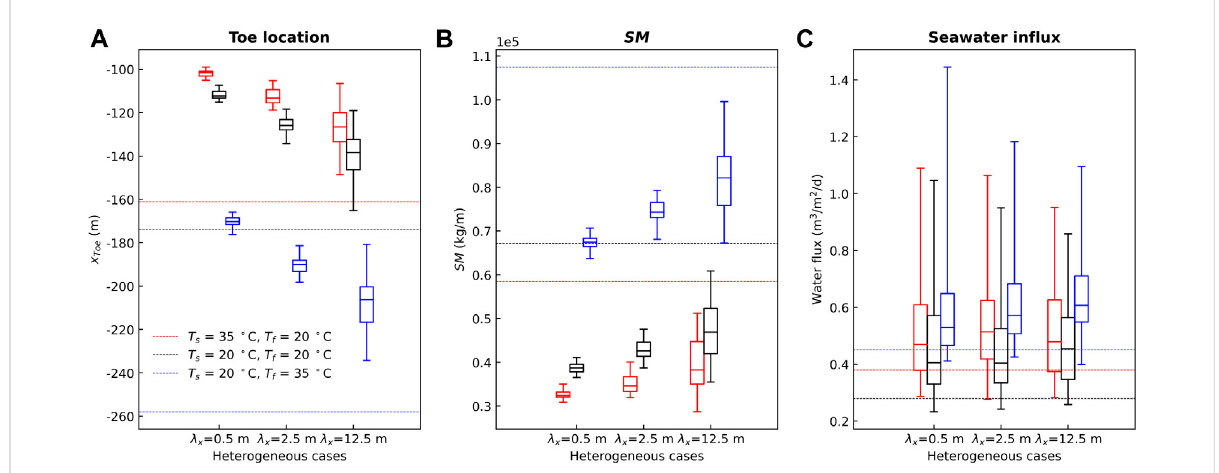
FIGURE 11 Box plots ( n = 50) for heterogeneous aquifers under different correlation lengths ( λ x = 0.5, 2.5, and 12.5 m, respectively) and FW-SW temperaturecontrasts.The left-hand, middle andright-handpanels aretheresultsfor (A) thetoelocation, (B) thetotalamountofsaltmassstoredin the aquifer ( SM ), and (C) the total seawater in fl ux across the aquifer-sea interface, respectively. σ 2 ln k is fi xed at 1. The dashed lines are the results for homogeneous aquifers. T s and T f are seawater and freshwater temperatures, respectively.